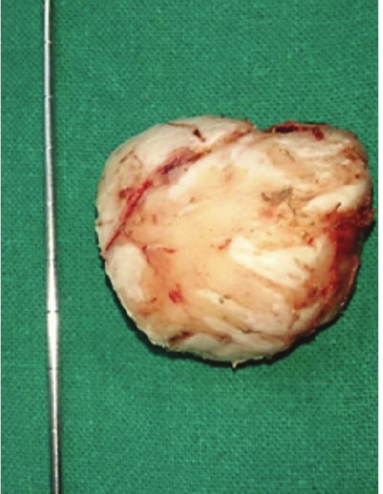
Figure 4: The excised bony lesion.